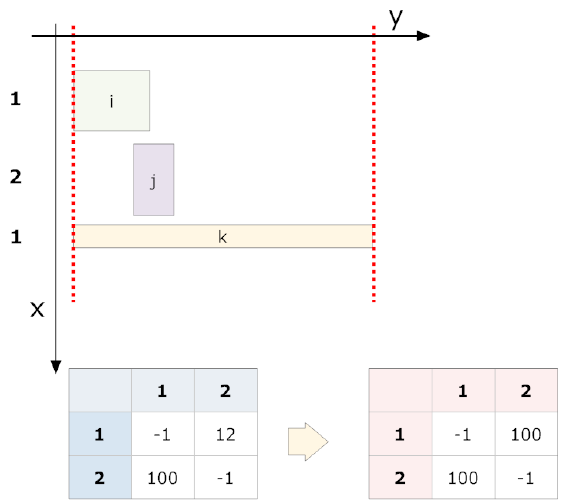
Figure 19. The second grouping cycle located on the right consists of group (1), which now contains two fragments. The described procedure is repeated.